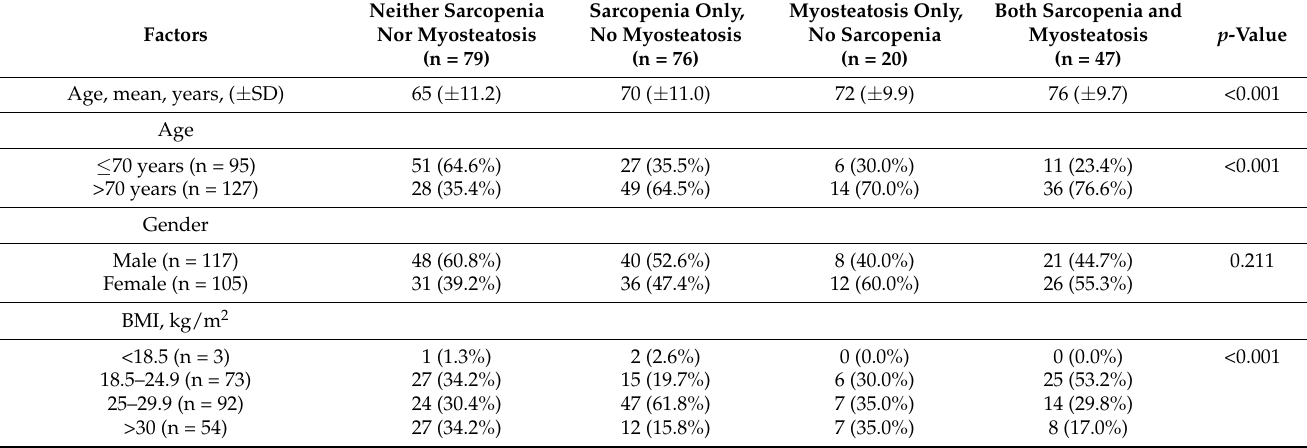
Table 2. Distribution of clinocopathological factors in myosteatosis and sarcopenia patient groups.